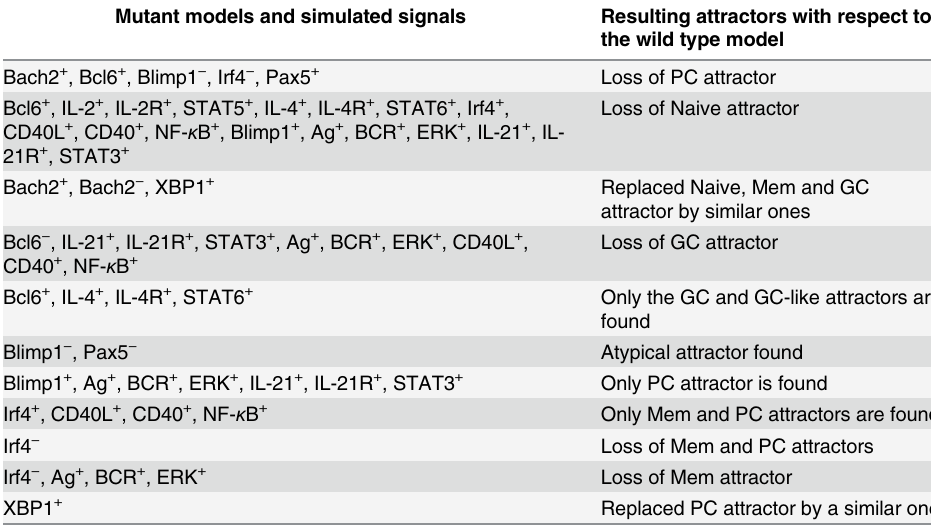
Table 5. Summary of the simulated mutants and external signals. Mutant models and simulated signals Resulting attractors with respect to the wild type